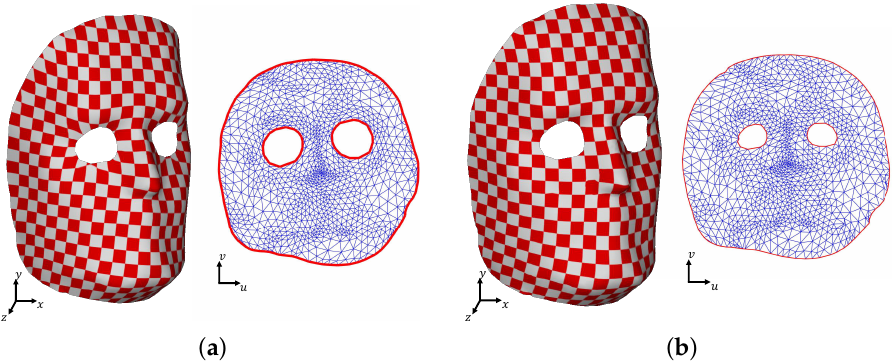
Figure 11. Data set Mask. Hole-distorted and undistorted heat-geodesic parameterizations. ( a ) Parameterization of M . 3D texture map (left) and 2D Φ coordinates (right). Distorted at holes and concavities. ( b ) Undistorted parameterization with underlying surface M ∗ . 3D texture map (left) and 2D Φ coordinates (right).